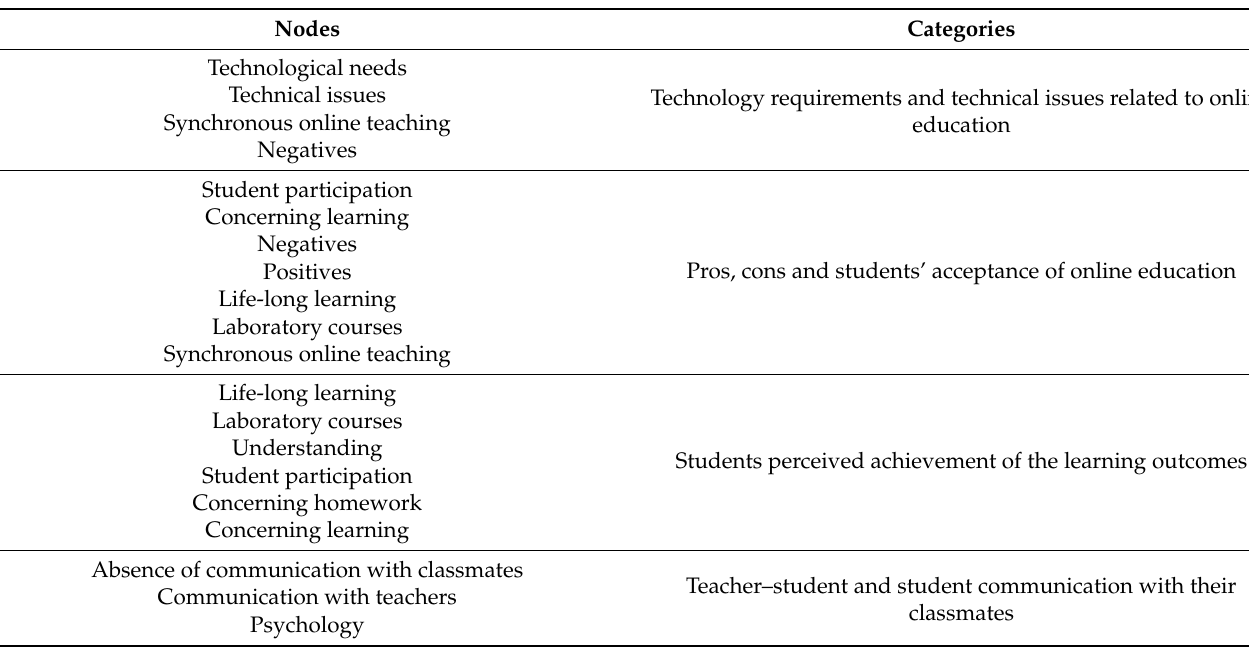
Figure 1. Example of codes creation. Nodes are corresponded to concepts, properties, categories or relationships. From the nodes, four categories emerged that consisted of three or more codes (Table 3). The four categories are (i) technology requirements and technical issues related to online education, (ii) pros, cons and students’ acceptance of online education, (iii) students perceived achieve- ment of the learning outcomes and (iv) teacher–student and student communication with their classmates. Table 3. Research questions and